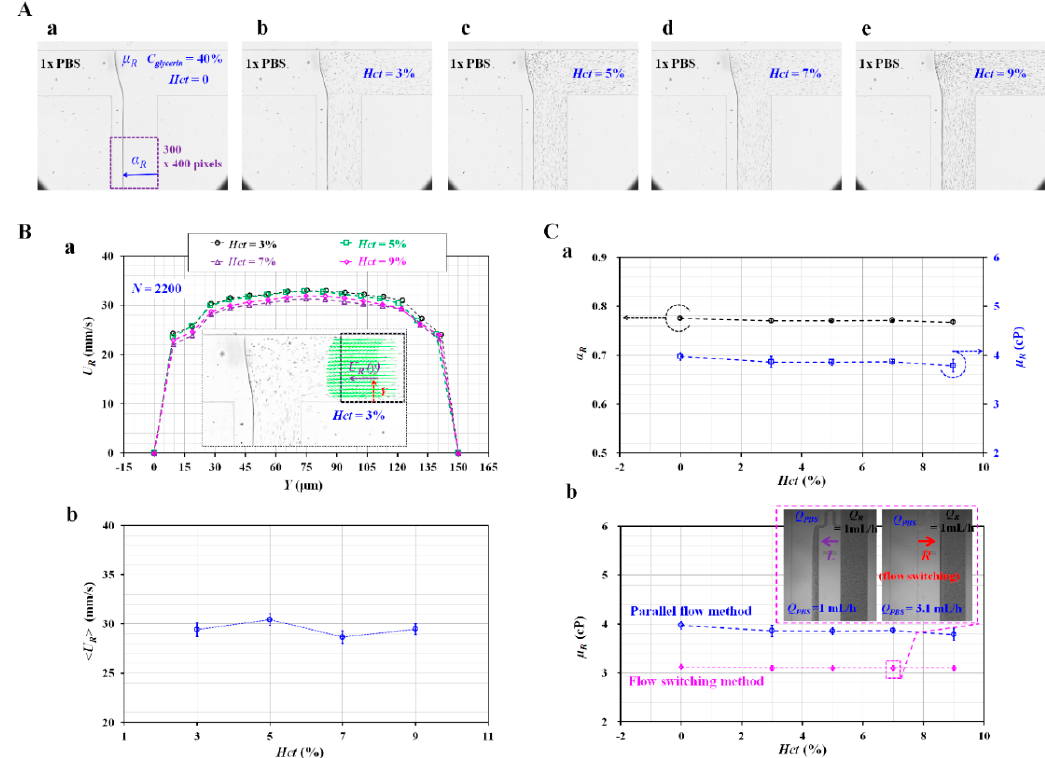
Figure 2. Contributions of RBCs added into the reference fluid to viscosity. 1 × PBS was delivered to the blood channel at a constant flow rate of 1 mL / h with a syringe pump (SP). The hematocrit ( Hct ) of reference fluid was adjusted by adding normal RBCs into 40% glycerin solution ( Hct = 0, 3%, 5%, 7%, and 9%). The reference fluid was delivered to the reference channel at a constant flow rate of 1 mL / h with an SP. ( A ) Microscopic images for obtaining interface ( α R ) in co-flowing channel with respect to Hct (( a ) Hct = 0, ( b ) Hct = 3%, ( c ) Hct = 5%, ( d ) Hct = 7%, and ( e ) Hct = 9%). ( B ) Contributions of hematocrit in reference fluid to velocity fields ( U R ). ( a ) Variation of velocity fields ( U R ) across reference channel width with respect to Hct . The inset showed a microscopic image and a velocity profile of the reference fluid with Hct = 3%. ( b ) Variations of < U R > averaged over a region of interest (ROI) with respect to Hct . ( C ) E ff ect of Hct in reference to fluid on viscosity ( µ R ). ( a ) Variations of α R and µ R with respect to Hct . ( b ) Comparison between the proposed method (i.e., the parallel-flow method with correction factor) and previous method (i.e., flow-switching method) with respect to Hct .